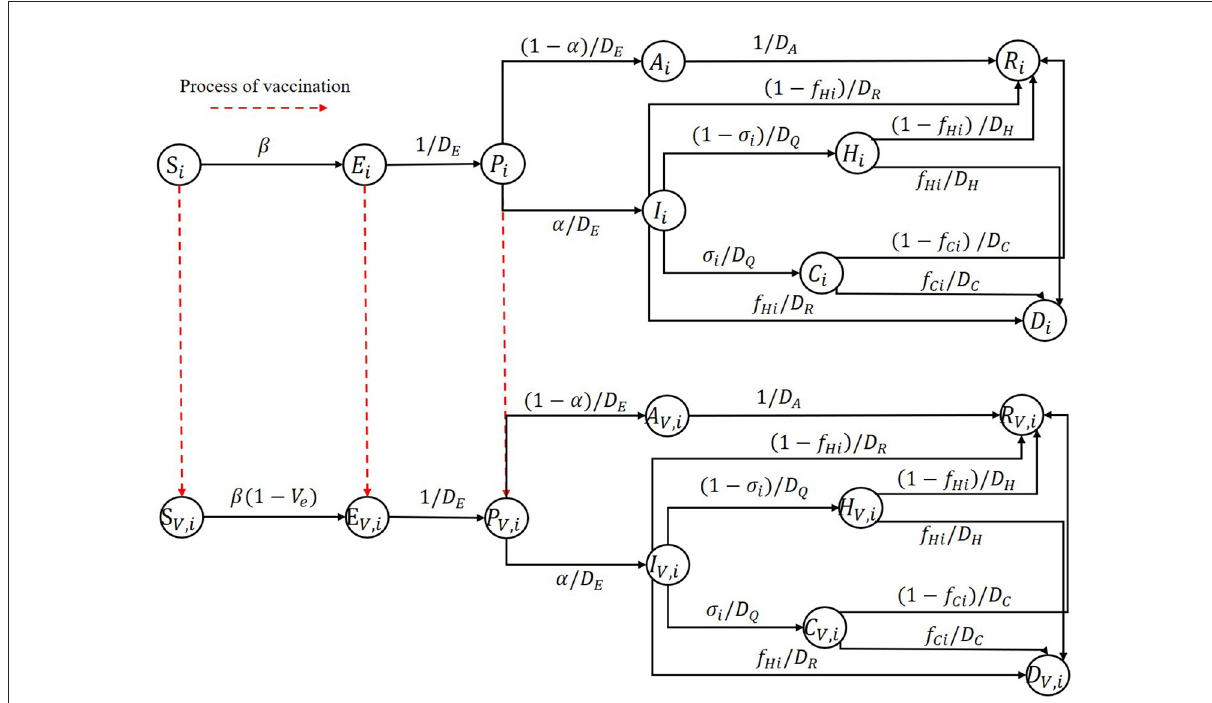
FIGURE1 Illustration diagram of the extended age-stratified SEIR